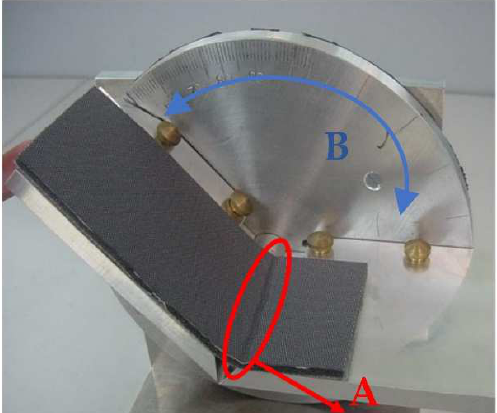
Figure 2. The evaluation of an appearance defect of a textile laminate: ( A ) formation of wrinkles on the fabric; ( B ) the moving of the rotating arm with the fabric.